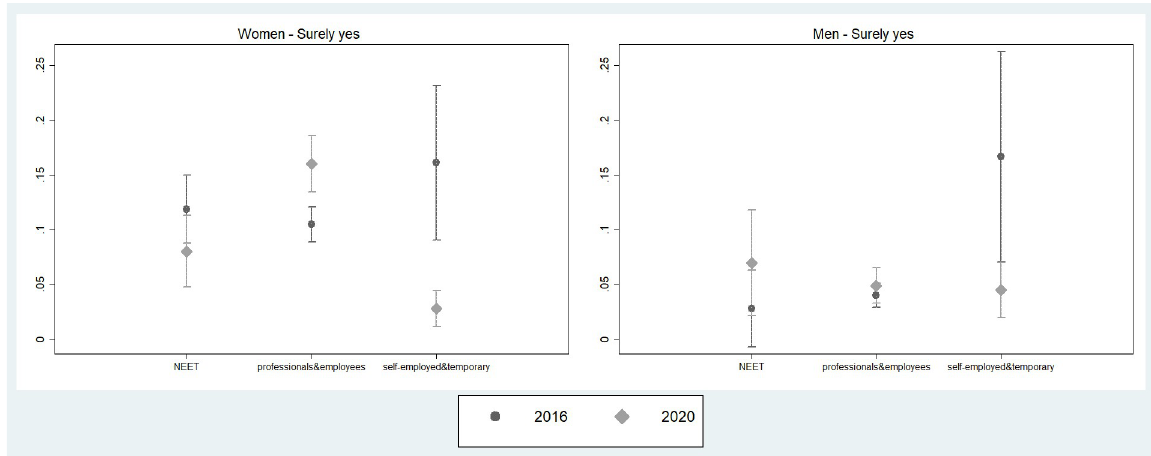
Fig 1. Predicted probabilities of intending to have a(nother) child (answer: “Surely yes”) in the next 12 months by occupational condition in 2016 and 2020 and by gender (confidence intervals for pair-wise comparisons at the 10% significance level). Note: Predicted probabilities bases on a generalized ordinal logit model, controlling for age class, education, marital status, presence of children, among those intending to have a child in the next 2 years (2020) or 3 years (2016). Full results are available in S1_1 Table in S1 Appendix. Confidence intervals are calculated to allow for multiple comparisons of predicted probabilities, i.e., to allow testing their statistical equality at an approximate 5% significance level. Overlap between a pair of intervals indicate that the corresponding predicted probabilities are not statistically different at the 10% level, while non-overlap indicate a significant difference. When differences of interest are significant at the 5% level, this is noticed in the text.